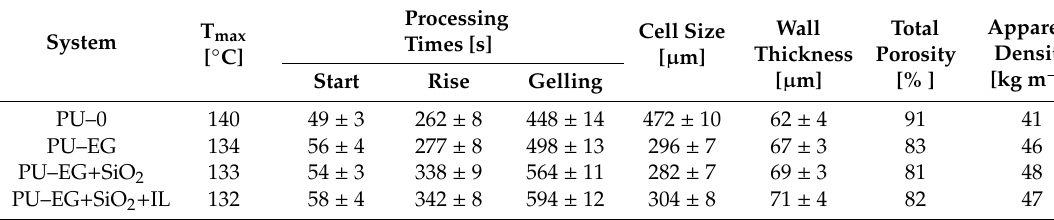
Table 2. Growth kinetics and structure parameters of RPUFs.